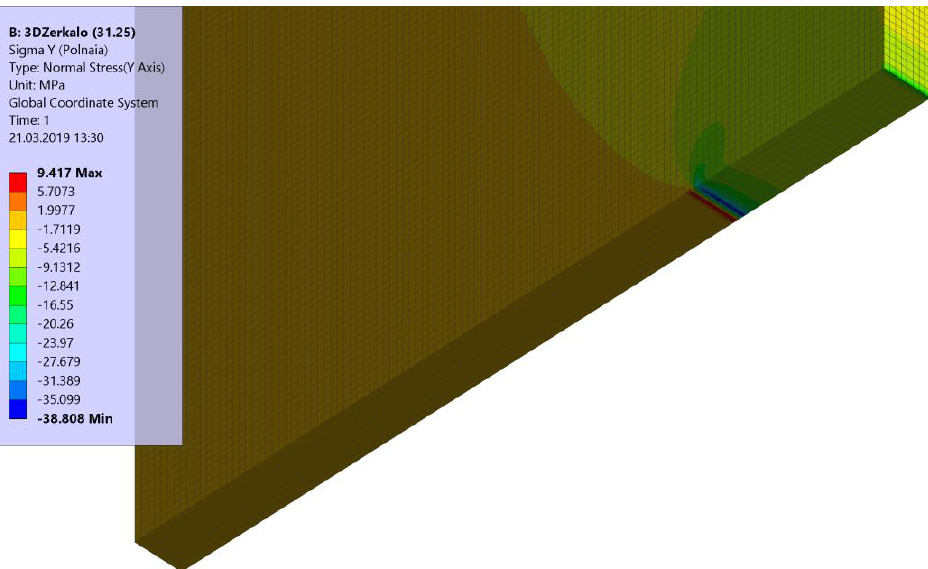
Fig. 4. Distribution of stress σ y in the lower part of the deep beam Linear deformations in the support part of the deep beam near the external surface z = H /2 reach the values of ε x = -0.0012, ε y = -0.0011, ε z = 0.0008. The highest values of angular deformations are γ xz ≈±0.0004, γ yz =-0.0002. The maximum value γ xy =0.0037 is higher than that of linear deformations γ xz ≈±0.0004, γ yz =-0.0002, and its negative value is as high as - 0.0007 (Fig. 5).